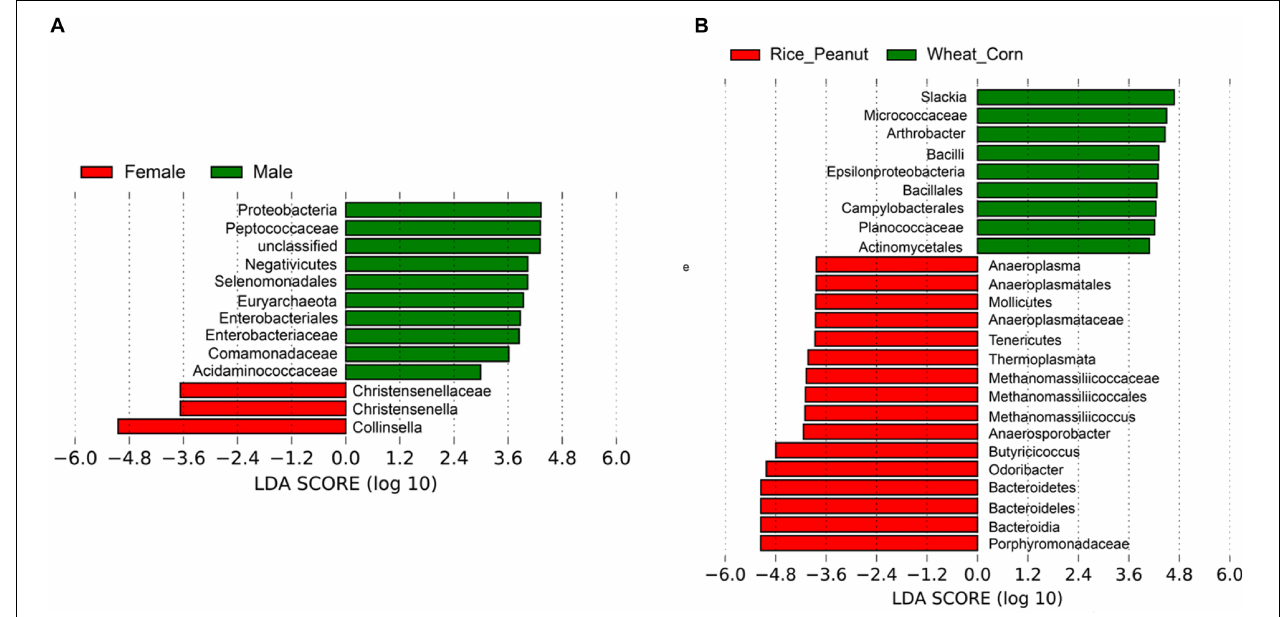
FIGURE 7 | LEfSe analysis showing microbiota OTUs significantly associated with sex and diet. (A) Differentially abundant genera related to sex determined using Kruskal–Wallis test ( p < 0.05) with LDA score > 2.0, (B) Differentially abundant genera related to diet determined using Kruskal–Wallis test ( p < 0.05) with LDA score >